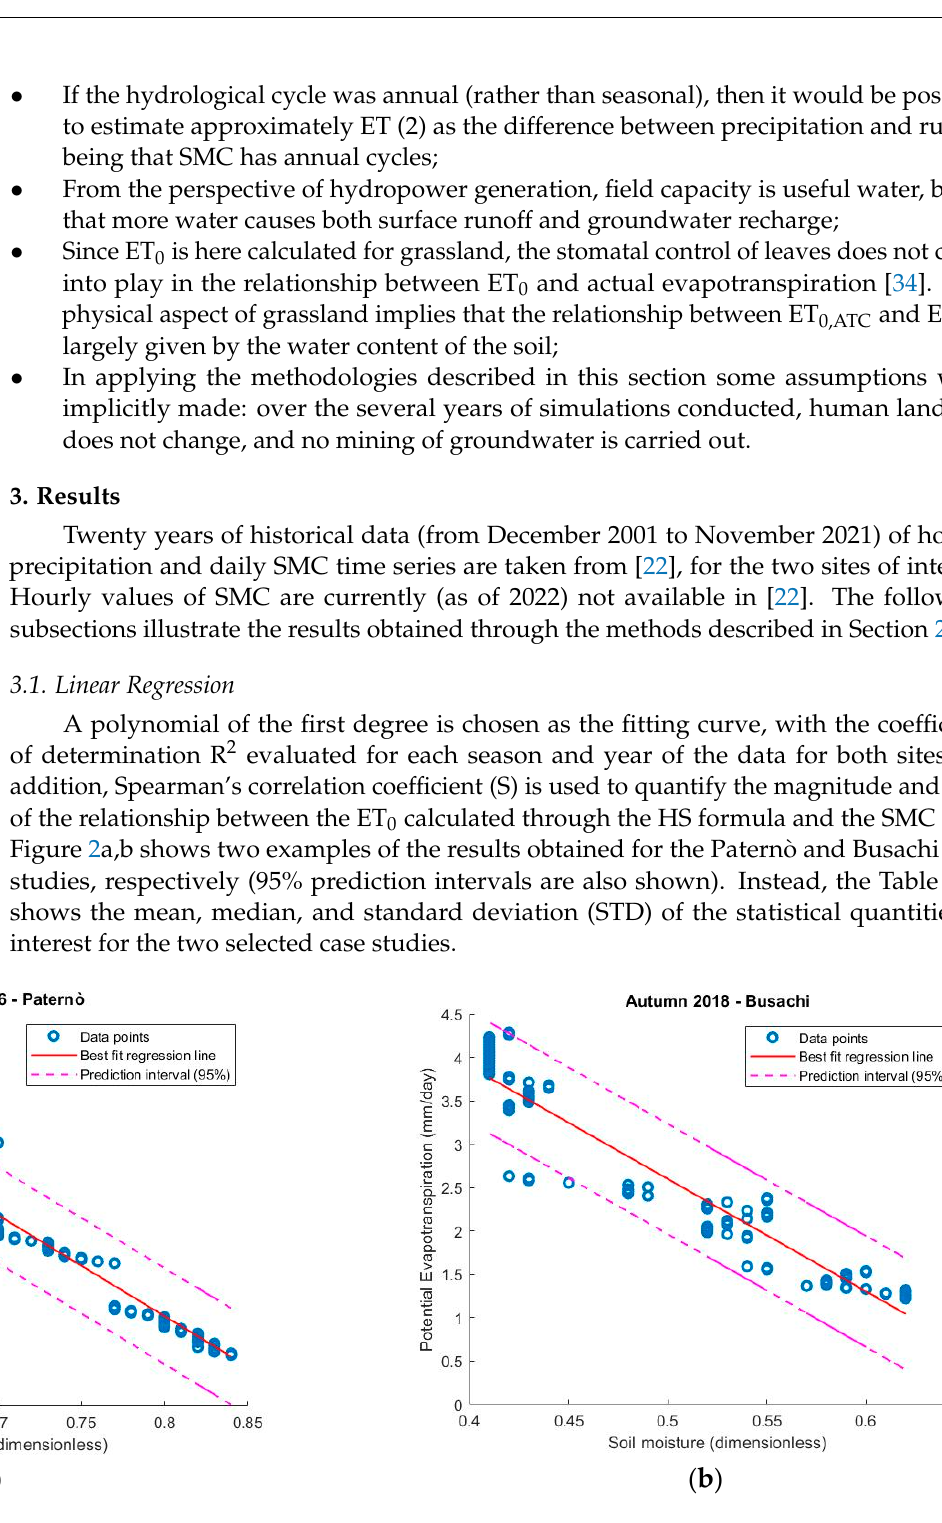
Figure 2. Fitting lines data points of soil moisture values versus potential evapotranspiration values for spring 2006 in Paternò ( a ) and autumn 2018 in Busachi ( b ). Additionally, plotted in purple are the 95% prediction intervals. Table 2. (a) Mean, median, and standard deviation (STD) of the correlation coefficients (Corr), coef- ficients of determination R (cid:2870) , and the slope of the fitting line, and its intercept, for the Paternò case study. (b) Mean, median, and standard deviation (STD) of the correlation coefficients (Corr), coeffi- cients of determination R 2 , and the slope of the fitting line, and its intercept, for the Busachi case study.